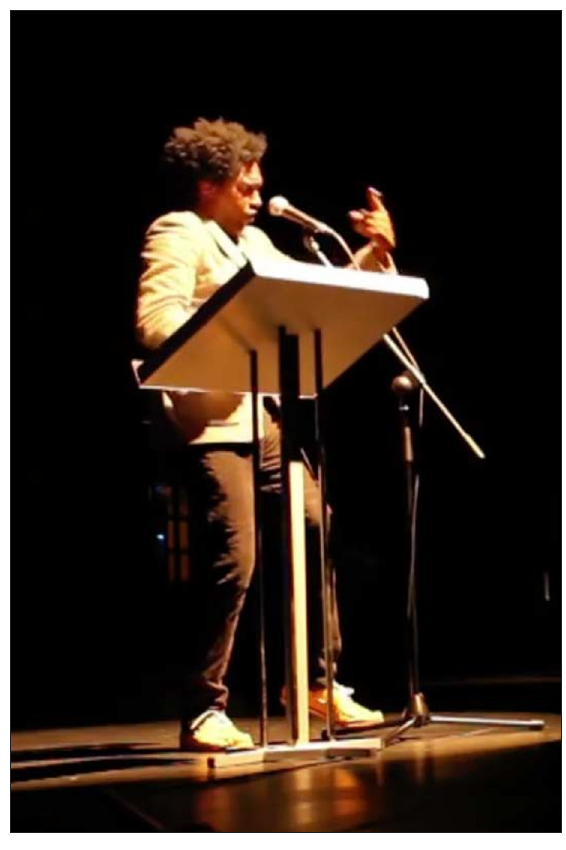
Figure 2: ‘Lemn Sissay – “I Hate You”’